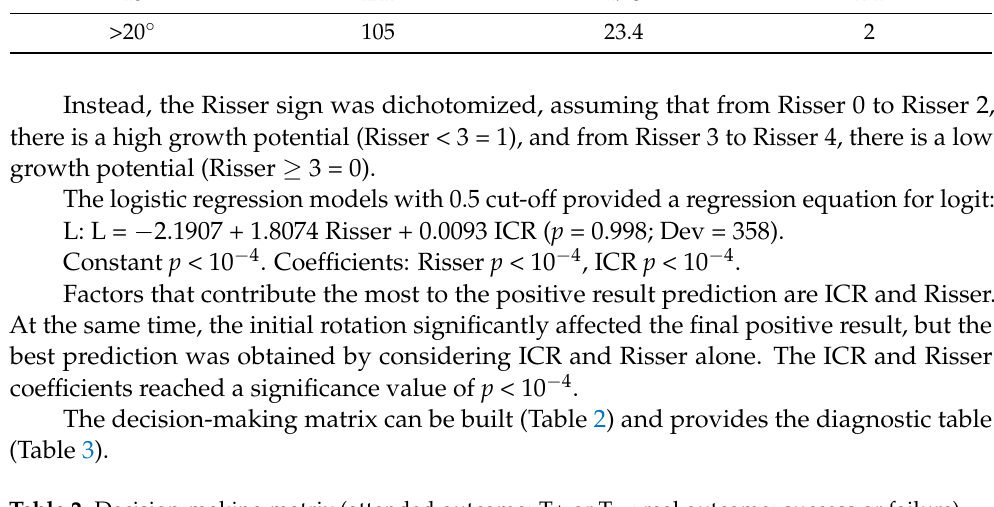
Table 1. Treatment efficacy.